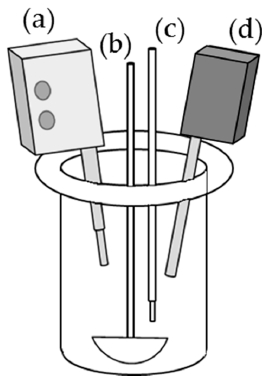
Figure 1. Experimental setup used during silent and sonicated experiments. ( a ) A 30 kHz probe is submerged from the top to supply ultrasound to the solution. ( b ) Overhead stirring is provided by a half-moon blade impeller. ( c ) A thermometer allowed accurately logging and controlling the temperature within this equipment. ( d ) PAT tools such as FBRM and FTIR were fitted to collect data on chord length distribution and solute concentration.